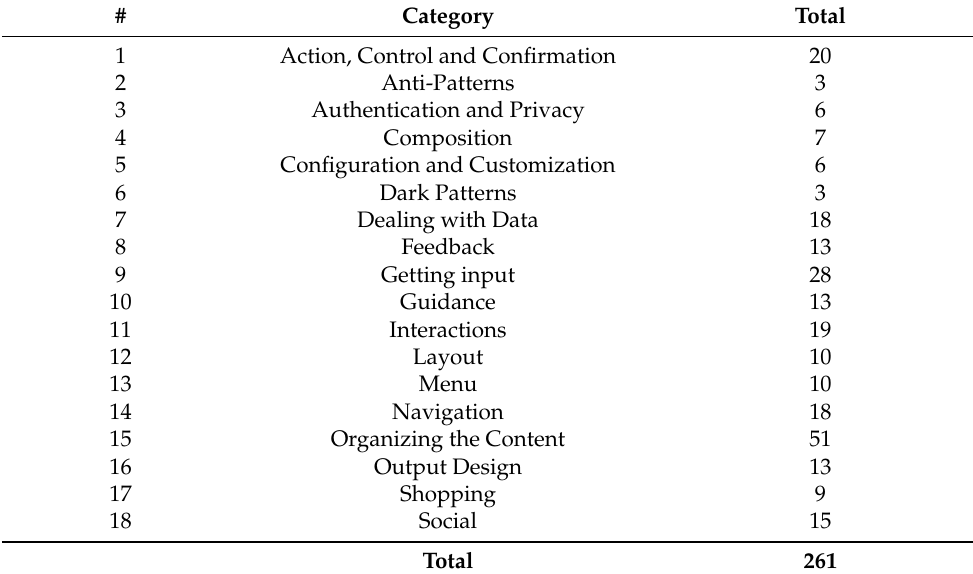
Table 6. Total MUIDPs by